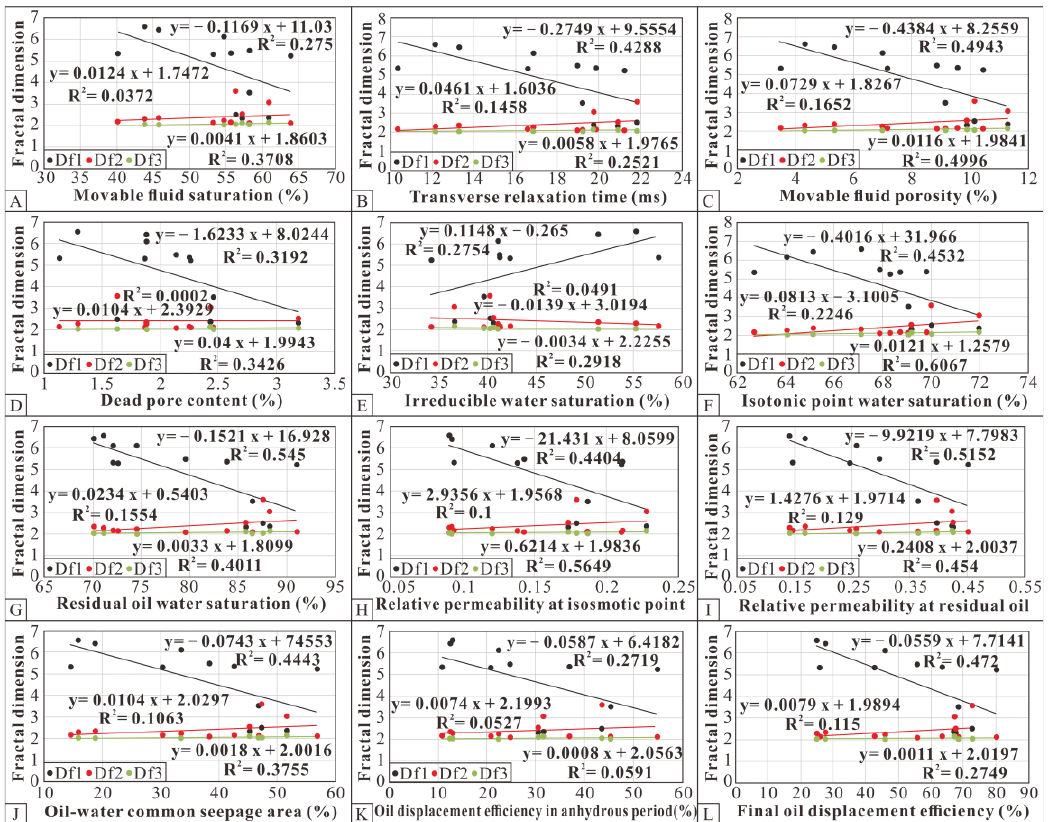
Figure 21. Correlation between the multifractal dimension and evaluation parameters of fluid seep- age capacity. ( A ) Correlation between movable fluid saturation and fractal dimension. ( B ) Correla- tion between T 2 and fractal dimension. ( C ) Correlation between movable fluid porosity and fractal dimension. ( D ) Correlation between dead pore content and fractal dimension. ( E ) Correlation be- tween irreducible water saturation and fractal dimension. ( F ) Correlation between isotonic point water saturation and fractal dimension. ( G ) Correlation between residual oil water saturation and fractal dimension. ( H ) Correlation between relative permeability at isosmotic point and fractal di- mension. ( I ) Correlation between relative permeability at residual oil and fractal dimension. ( J ) Cor- relation between oil-water common seepage area and fractal dimension. ( K ) Correlation between oil displacement efficiency in anhydrous period and fractal dimension. ( L ) Correlation between final oil displacement efficiency and fractal dimension.